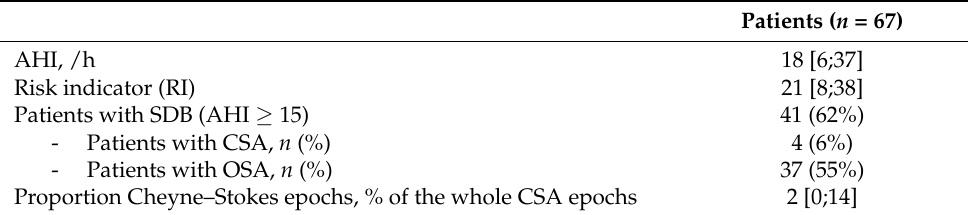
Table 3. Respiratory polygraphy in 67